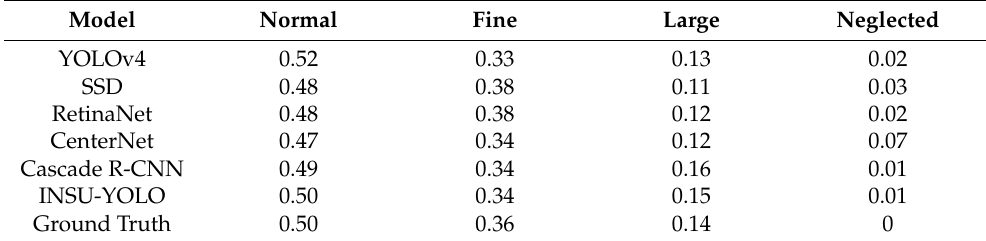
Table 4. Accuracy of defect detection.